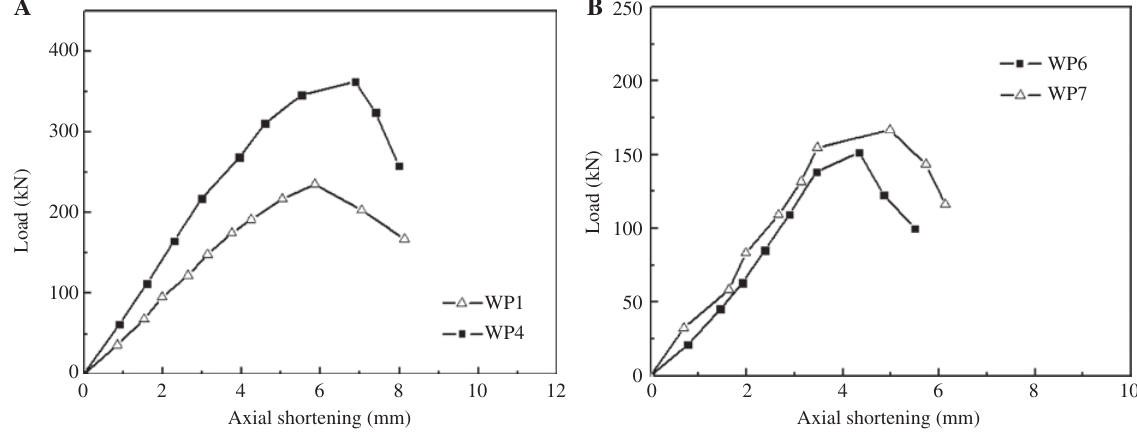
= 3.2 mm and (B) h = 50 mm, s = 100 mm, t w